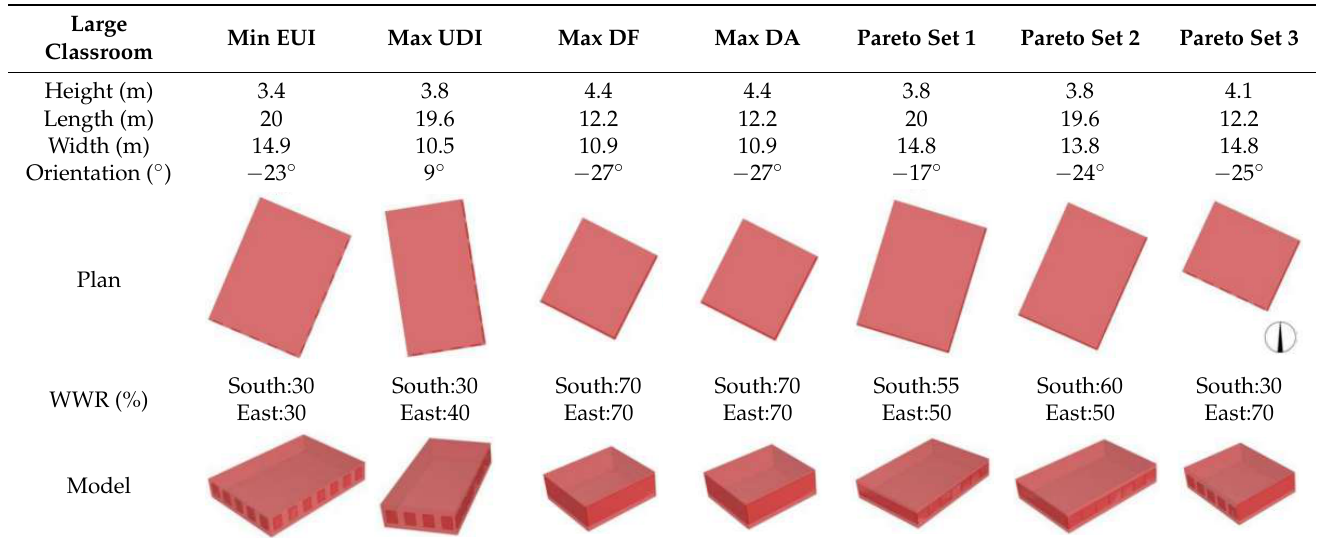
Table 18. Genomes in detail and phenotype outputs for large-sized classrooms with east and south facade